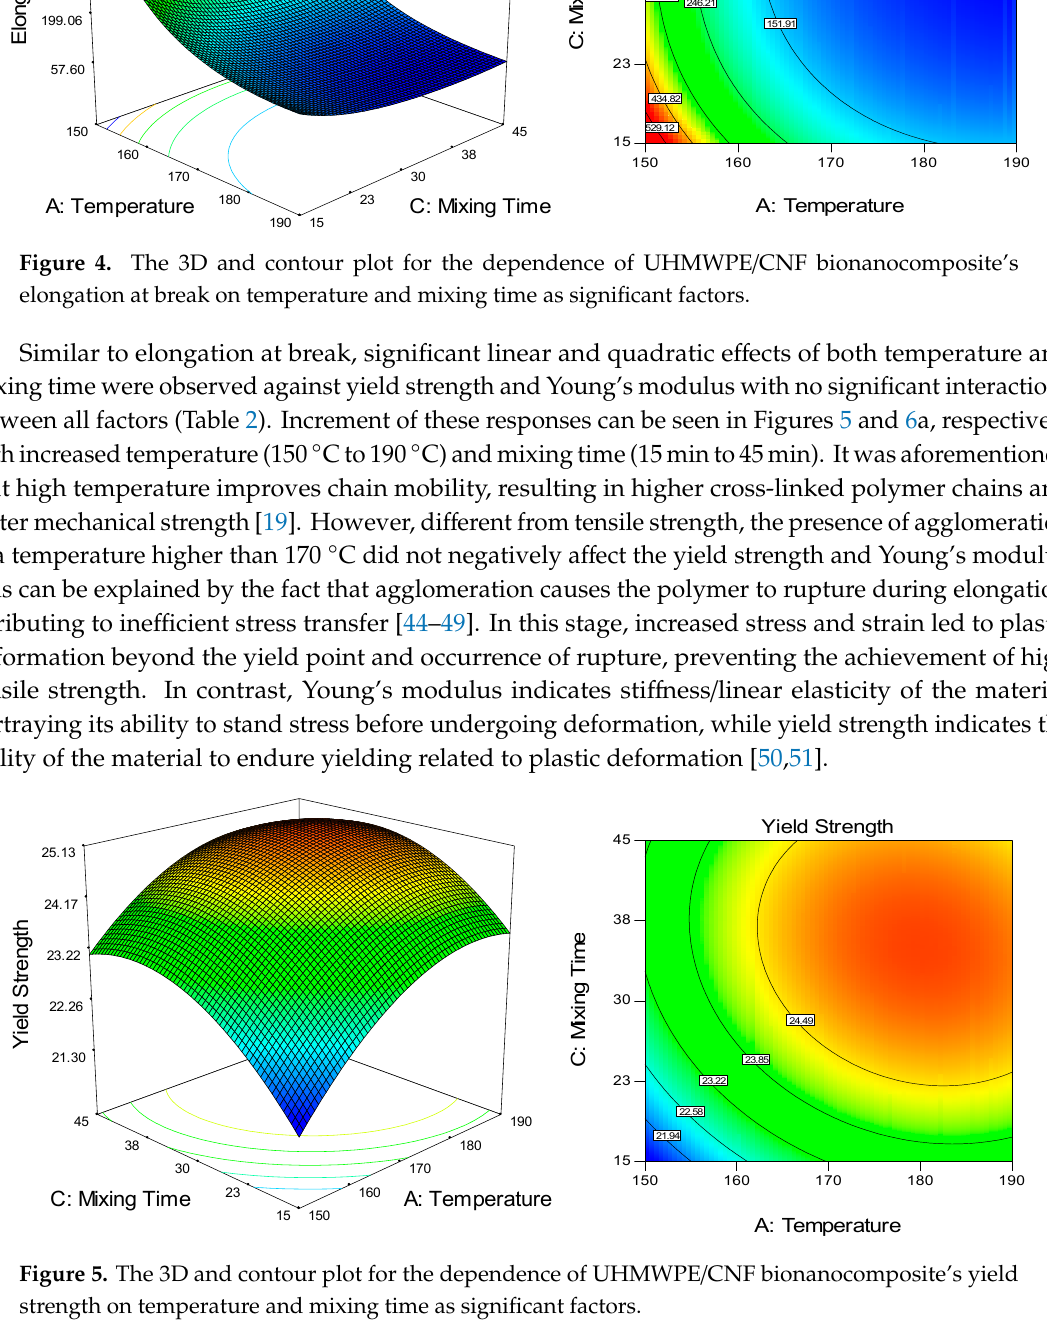
Figure 6. The 3D and contour plot for the dependence of UHMWPE/CNF bionanocomposite’s Young’s modulus on ( a ) temperature and mixing time, and ( b ) temperature and rotational speed as significant factors. Meanwhile, CNF dispersion and distribution in UHMWPE were found to be unaffected by rotational speed, as proved by insignificant changes of tensile strength, yield strength, and